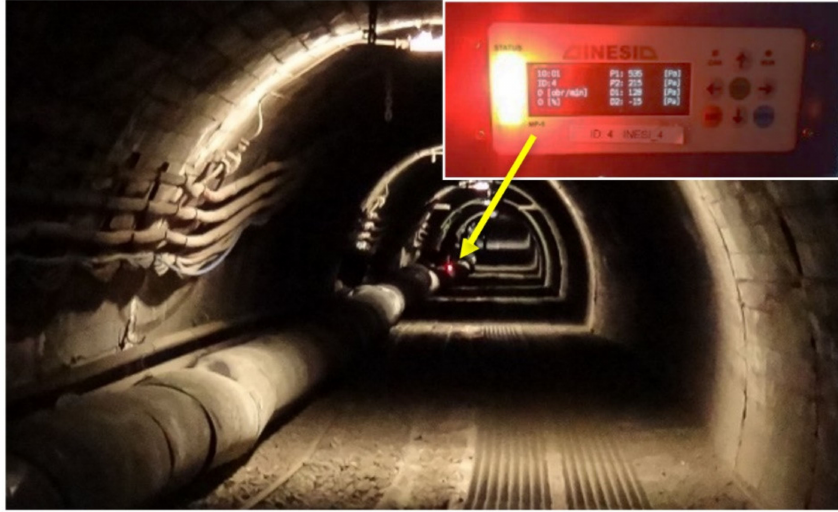
Figure 15. Response of the measuring module for the connector unsealing (red